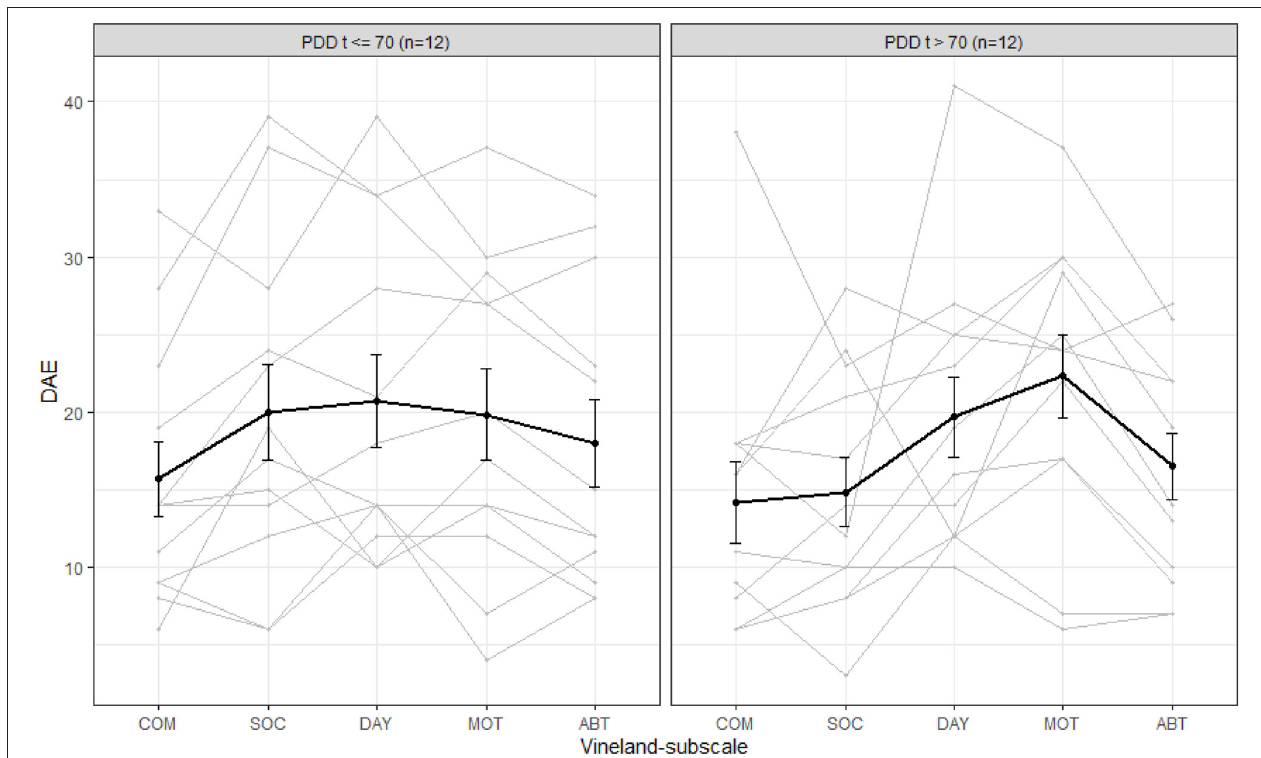
FIGURE 5 | Average (bold line) and individual behavior profiles on the Vineland for children with and without CBCL-scores in the clinical range for pervasive developmental disorder (PDD). COM, communication; SOC, social behavior; DAY, daily skills; MOT, motor skills; ABT, adaptive behavior total score; DAE, developmental age equivalent in months based on Bayley-III cognition scale. Please take into account: the average calendar age was 74 months (6.2